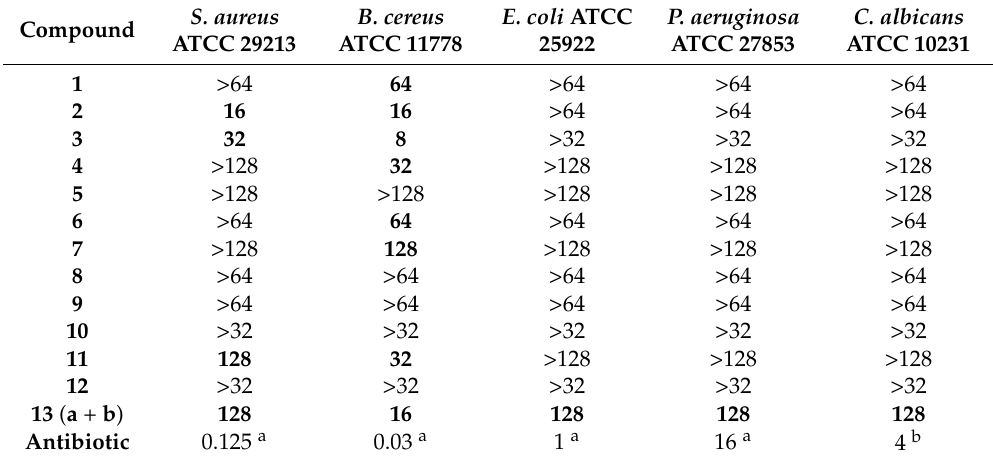
Table 3. MIC values ( µ g/mL) of compounds isolated from E. globulus